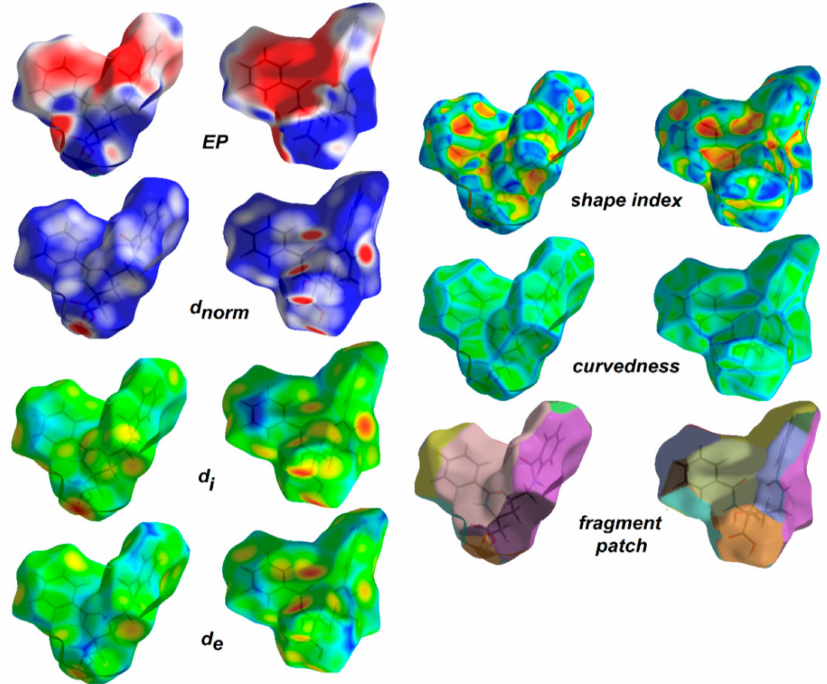
Figure 6. View of the 3D Hirshfeld surface of the title compound 1 mapped with d norm , showing basic synthons: C ( 6 ) [on the left], C ( 4 ) [in the middle] and C ( 9 ) [on the right], created by O-H ... O, N-H ... O and C-H ... O hydrogen bonds, respectively. The surfaces are shown as transparent to allow visualization of the orientation and conformation of the functional groups (on the left side: front; on the right: